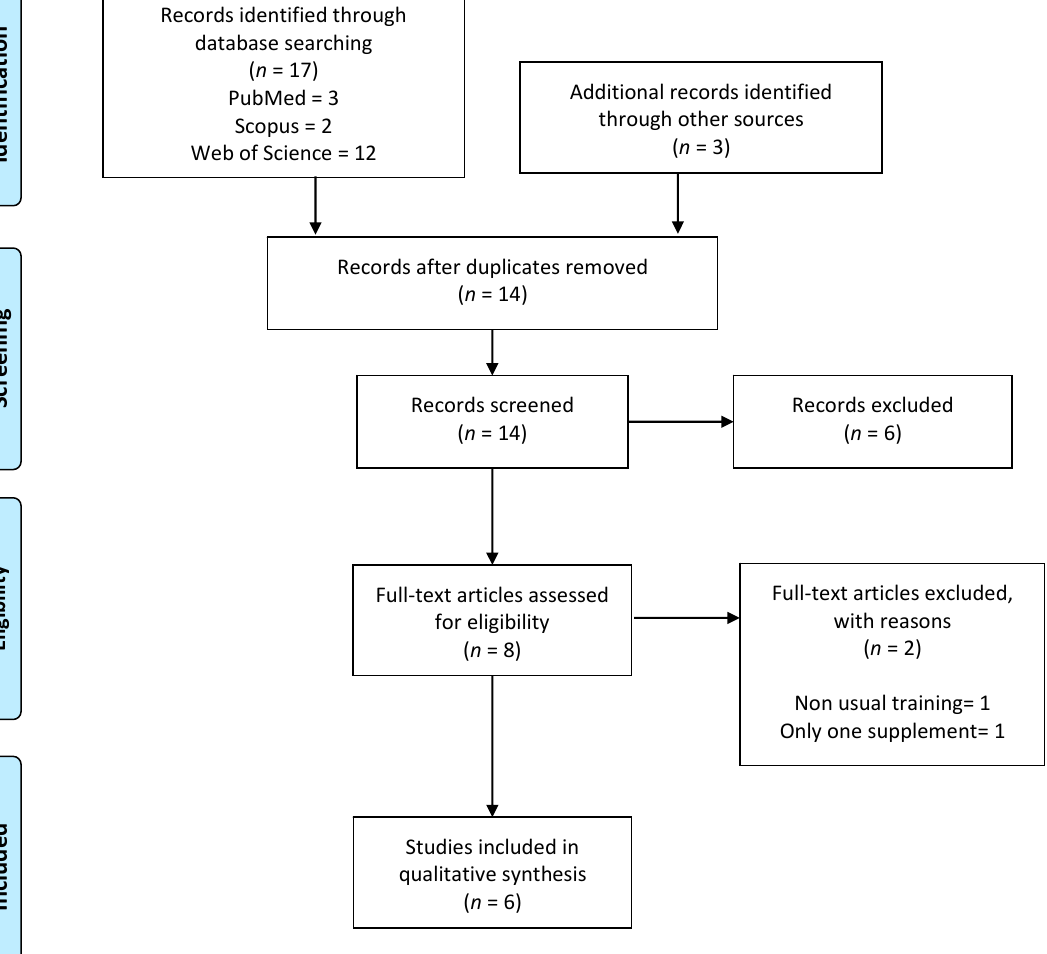
Figure 3. Preferred Reporting Items for Systematic Reviews and Meta-Analyses (PRISMA) flow Figure3. diagram.